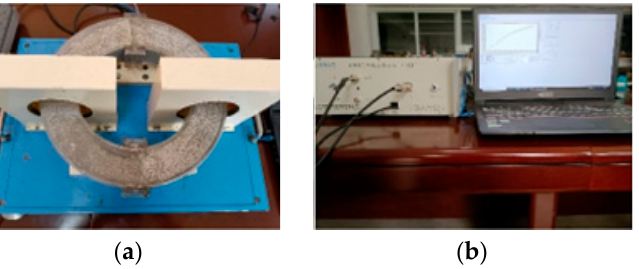
Figure 7. ( a ) The physical appearance of NCACII and ( b ) NCACII working pictures.